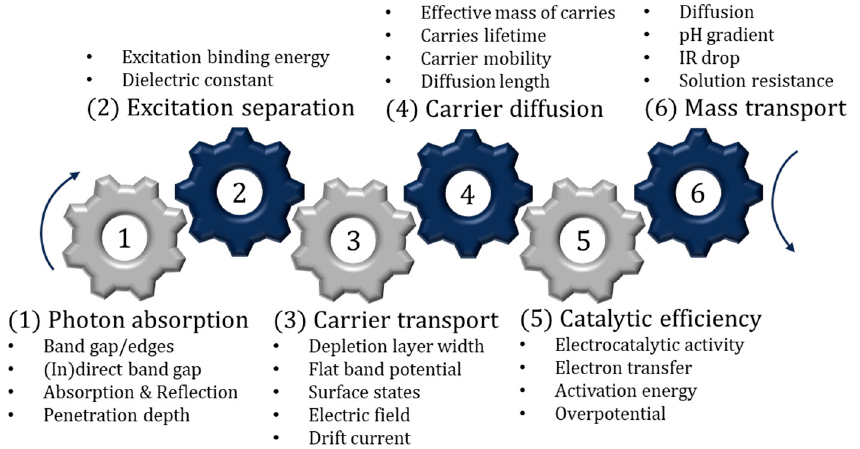
Figure 5. Sequential steps associated with photocatalysis and PECs.